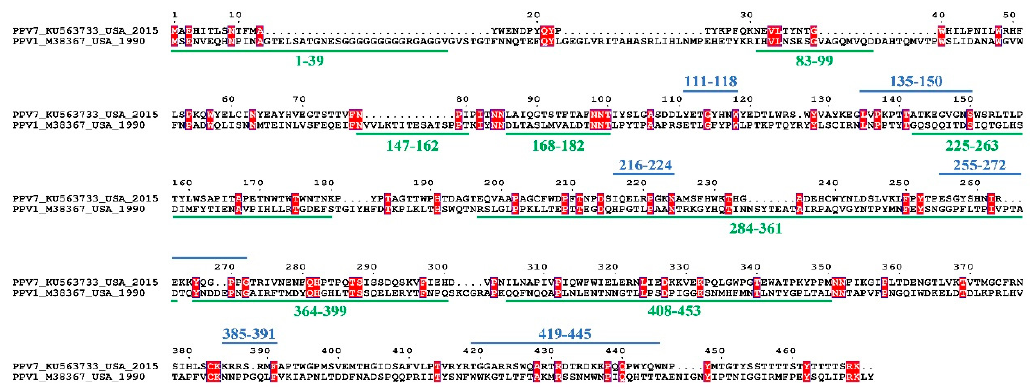
Figure 4. Sequence alignment of predicted PPV7 and identified PPV1 linear B cell epitopes from Cap. Blue lines represent predicted PPV7 B cell epitopes and green lines represent identified PPV1 B cell epitopes.